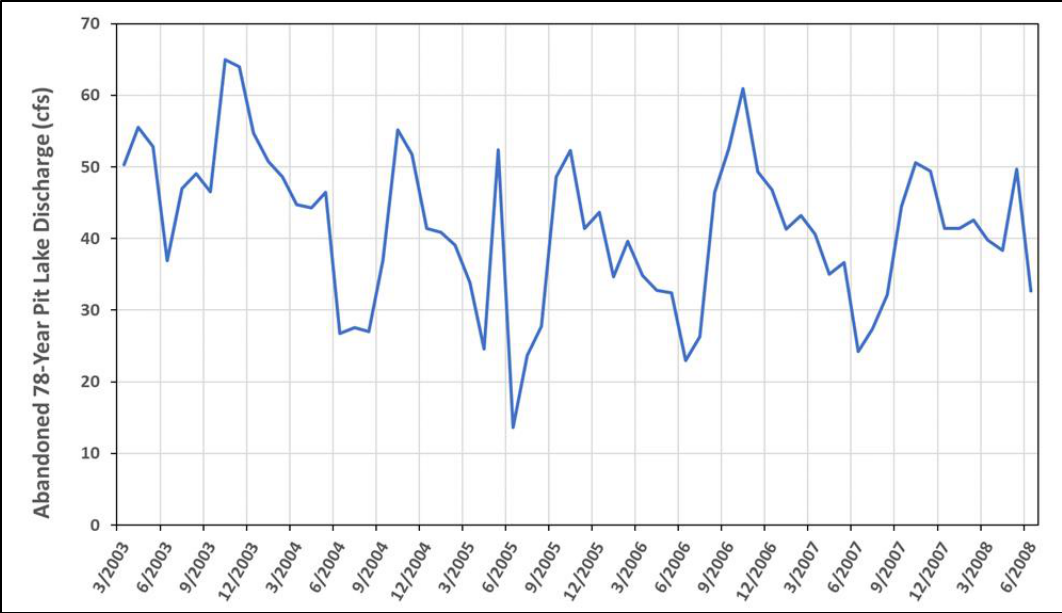
Figure 7. MIKE-SHE-imulated pit lake surface (overland) outflow to Upper Talarik Creek for the 78-year abandoned pit scenario. Pit lake overflow averages approximately 40 cfs and peaks at approximately 65 cfs, delivering pit lake water directly into Upper Talarik Creek drainage. Hourly weather data from the dates shown were used to predict post-closure conditions.